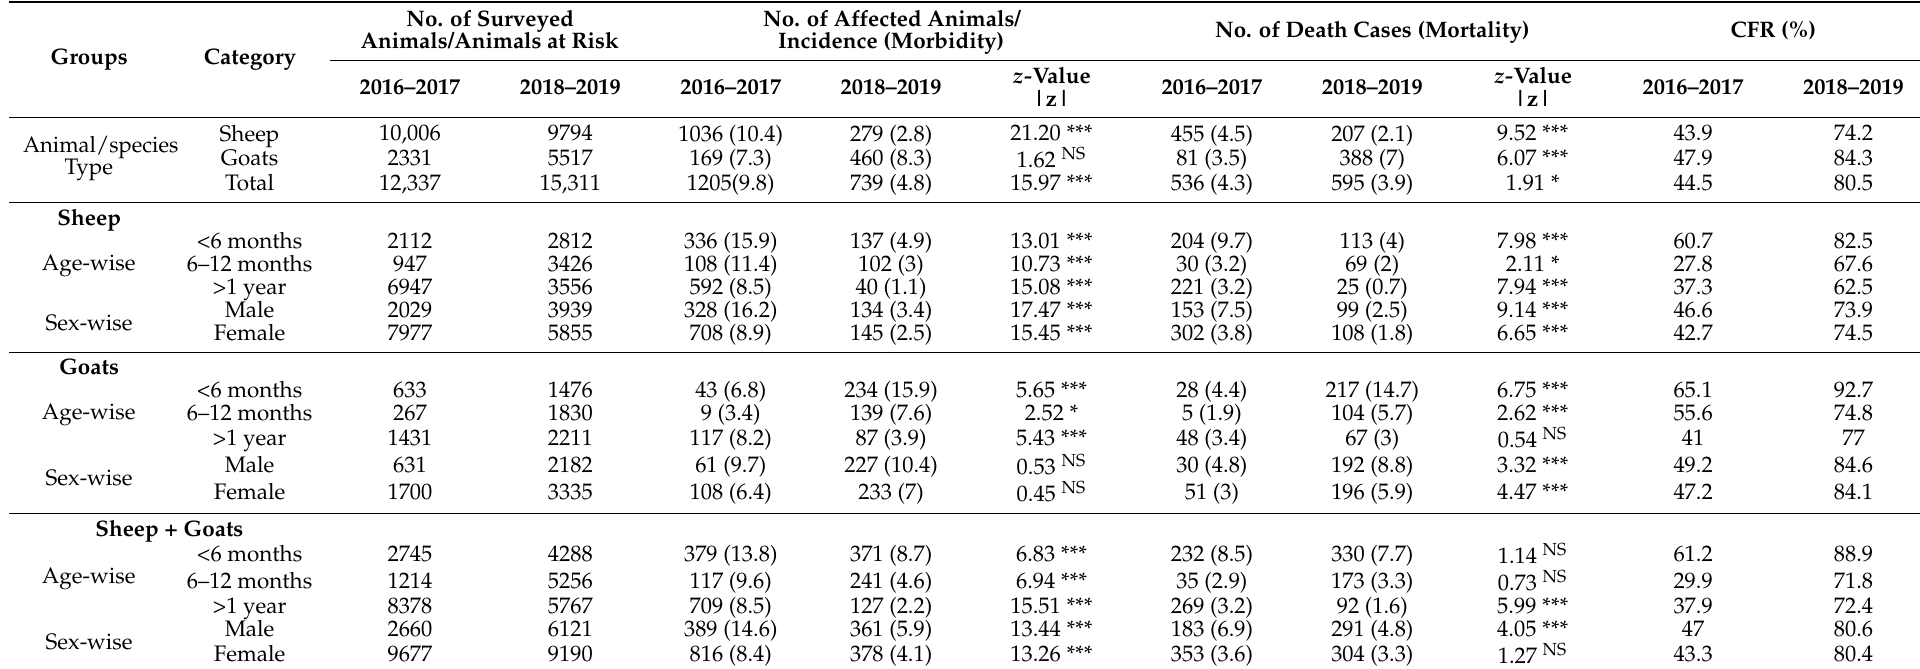
Table 2. Distribution of morbidity and mortality in sheep and goats due to PPR in